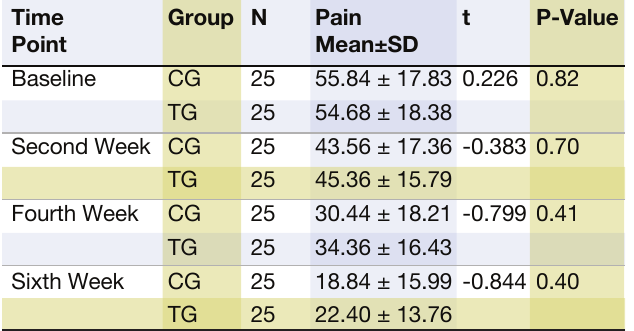
Table 10. Between Group Comparison of Participants’ Pain at Baseline, Second, Fourth and Sixth Week of Intervention